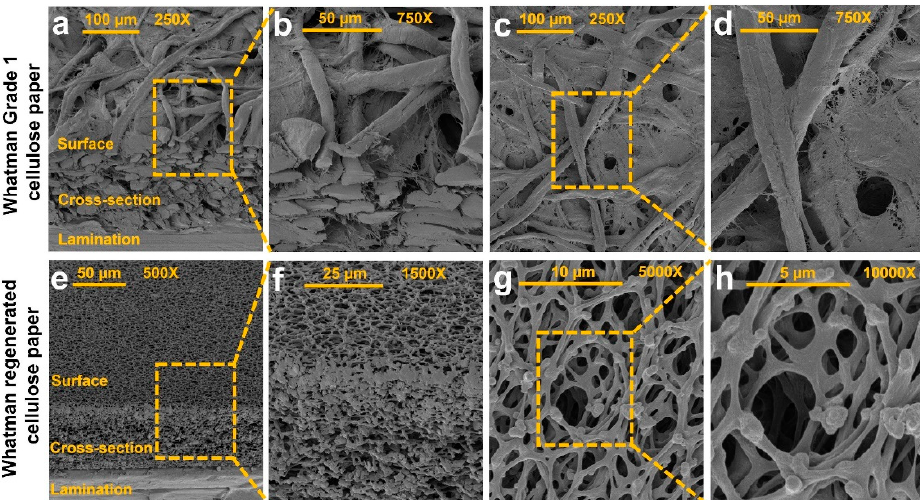
Figure 3. Physical characterization of Whatman grade 1 and regenerated cellulose paper. ( a ) SEM image with 250× magnification and ( b ) 750× magnification of the laminated Whatman grade 1 cellulose paper, showing the 45° view of surface and cross-section. ( c ) SEM image with 250× magnification and ( d ) 750× magnification of the Whatman grade 1 cellulose paper surface. ( e ) SEM image with 500× magnification and ( f ) 1500× magnification of the laminated Whatman regenerated cellulose paper, showing the 45° view of surface and cross-section. ( g ) SEM image with 5000× magnification and ( h ) 10,000× magnification of the Whatman regenerated cellulose paper surface.